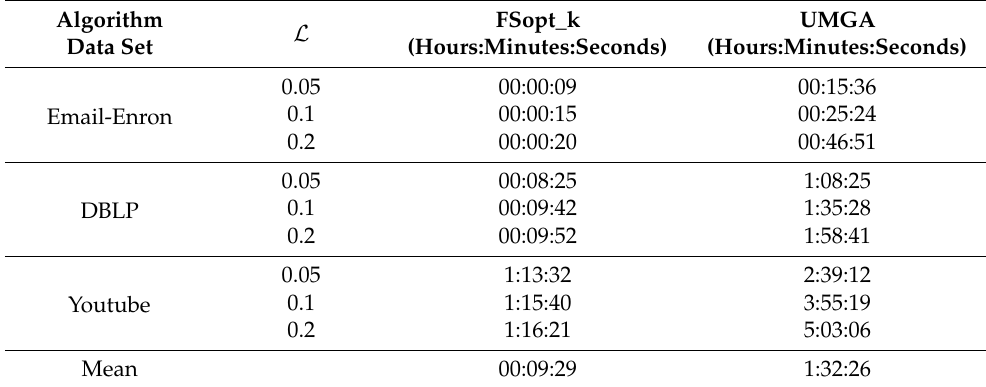
Table 3. Comparison of FSopt_k and UMGA with respect to the runtime.